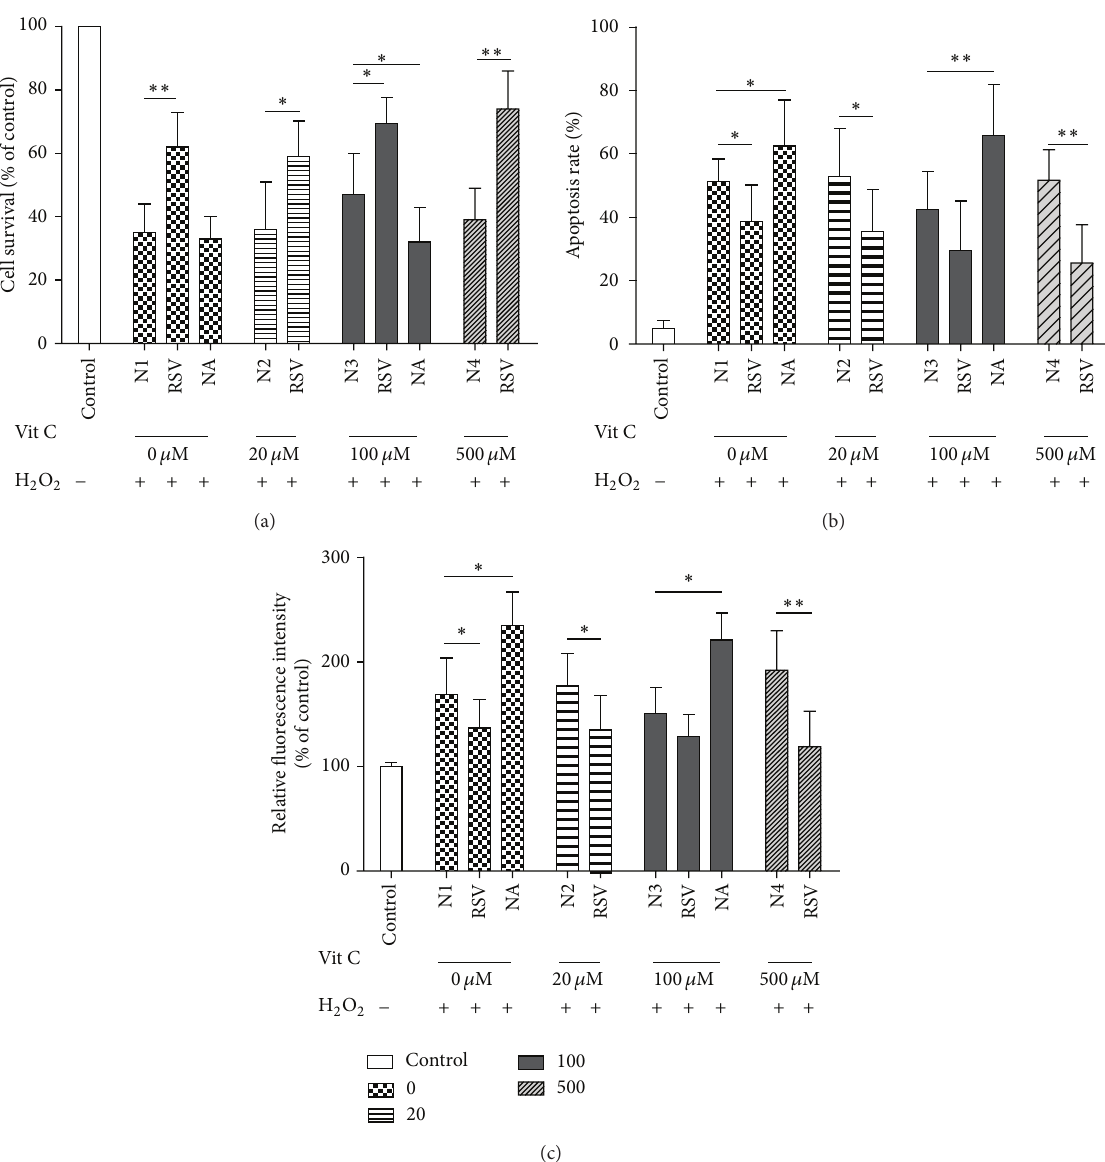
Figure 3: SIRT1 changed the effects of Vit C on viability, apoptosis, and intracellular ROS of ARPE-19 cells induced by H 2 O 2 . ARPE-19 cells were preincubated with RSV (10mM) or NA (5 mM) for 4h. Then, cells were exposed to H 2 O 2 for 12 h after treatments of indicated concentration of Vit C. Viability (a), apoptosis (b), and intracellular ROS (c) were measured and compared among different groups. N1, N2, N3, and N4 were standing for the cells treated with H 2 O 2 and without Vit C preincubation, cells treated with H 2 O 2 and 20 𝜇 M Vit C, cells treated with H 2 O 2 and 100 𝜇 M Vit C, and cells treated with H 2 O 2 and 500 𝜇 M Vit C, respectively. Single treatment was performed in triplicate. Statistical significance was expressed as ∗ 𝑃 < 0.05 and ∗∗ 𝑃 < 0.01